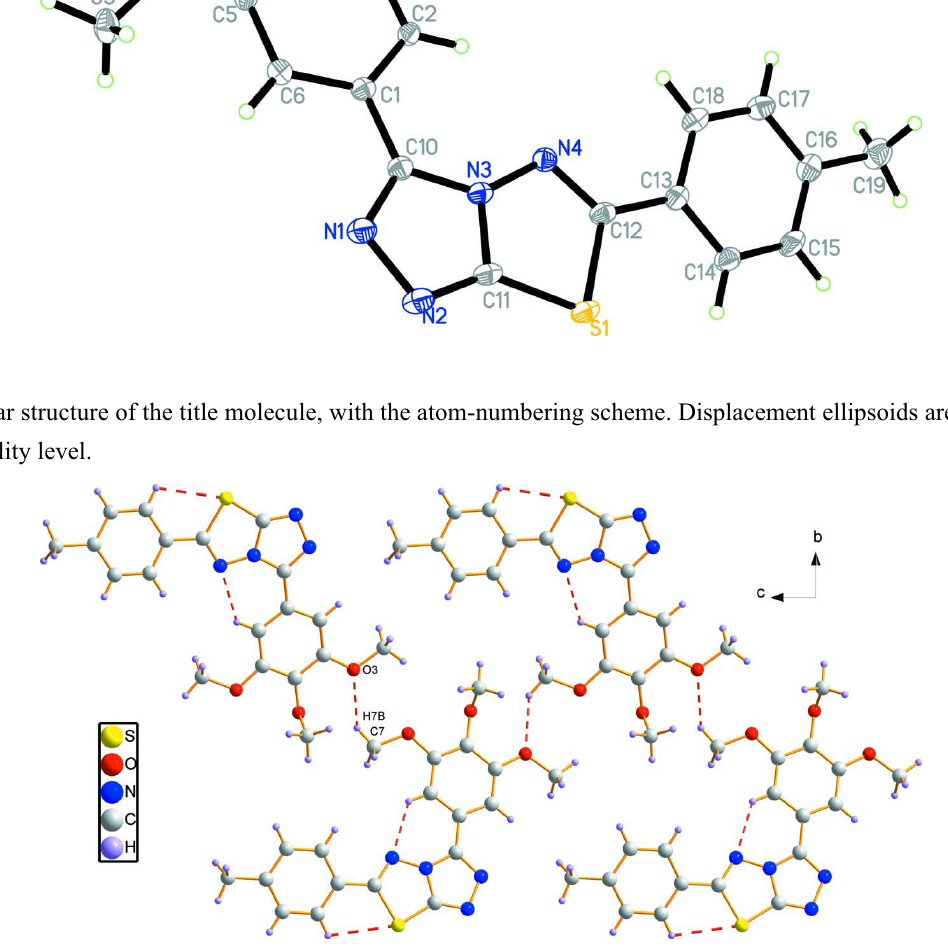
A partial packing diagram of the title compound. Hydrogen bonds are shown as dashed lines. [Symmetry code: O3 (x+1/2, -y+3/2,